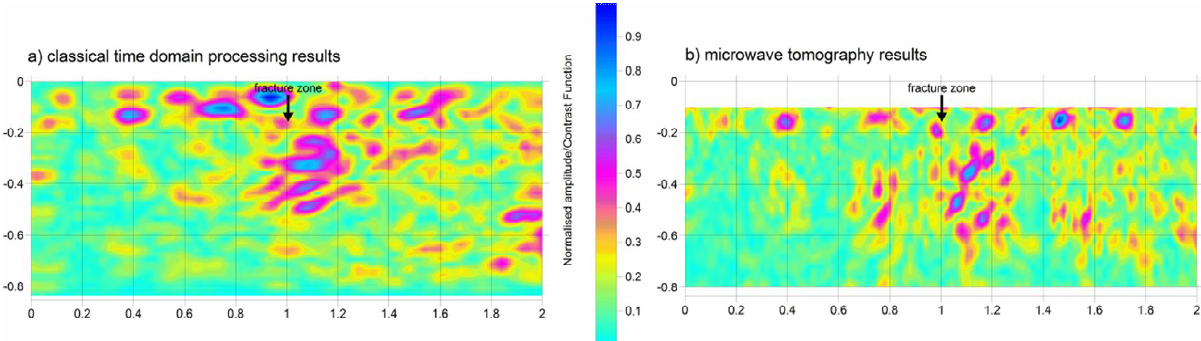
Fig. 4. Radargram carried out on a floor of the Prefecture of Chania building. (a) full classical time domain processing; (b) microwave tomography